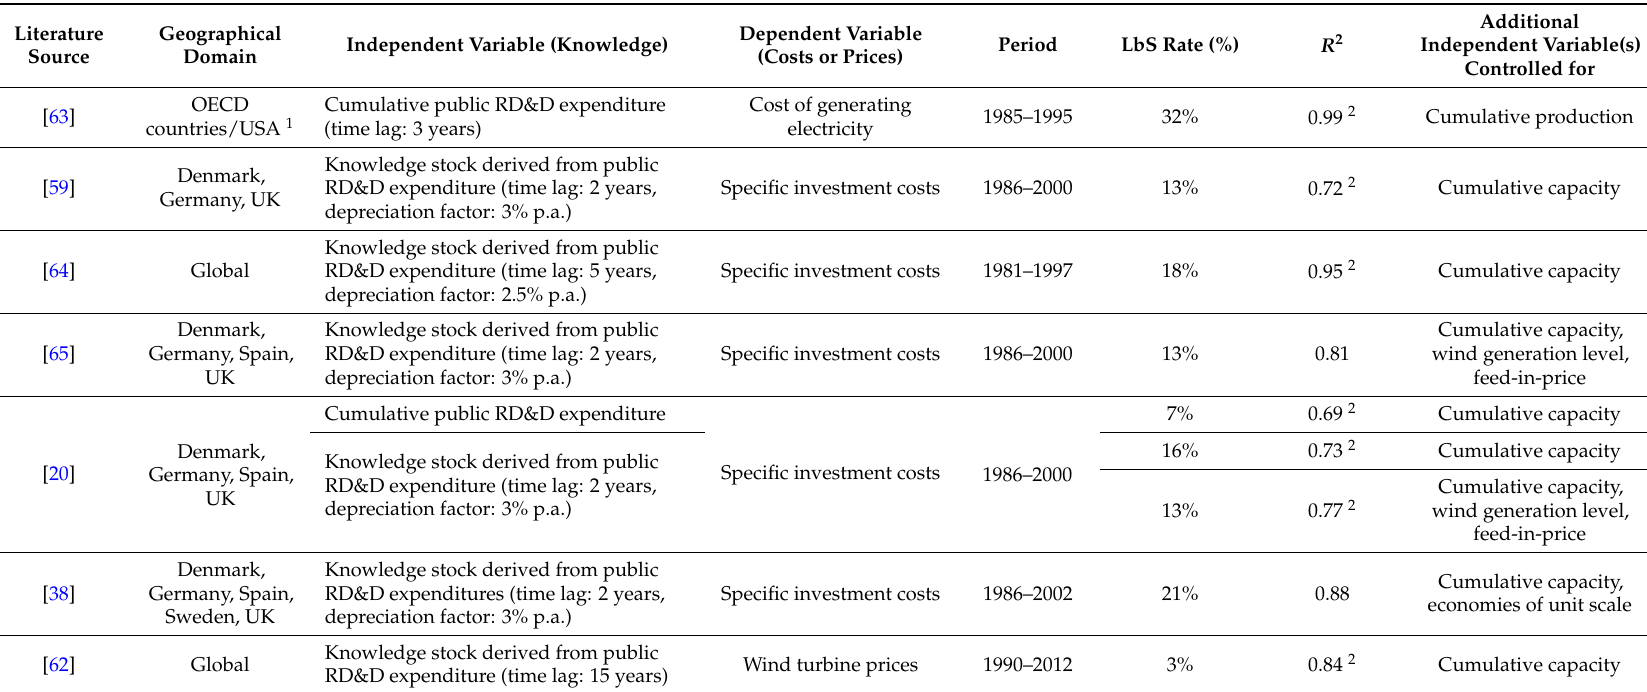
Table 1. Literature estimates for the learning-by-searching rate of onshore wind power